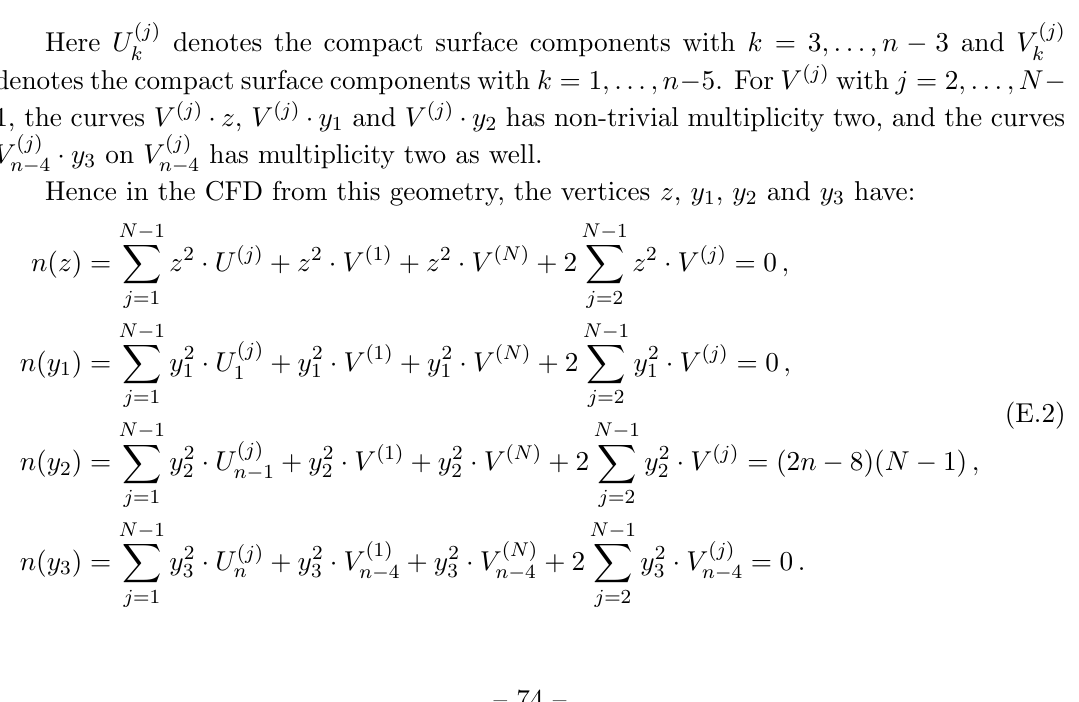
Figure 7. The con(cid:12)guration of curves in the KK resolution geometry of non-minimal ( D n ; D n ) conformal matter with order N